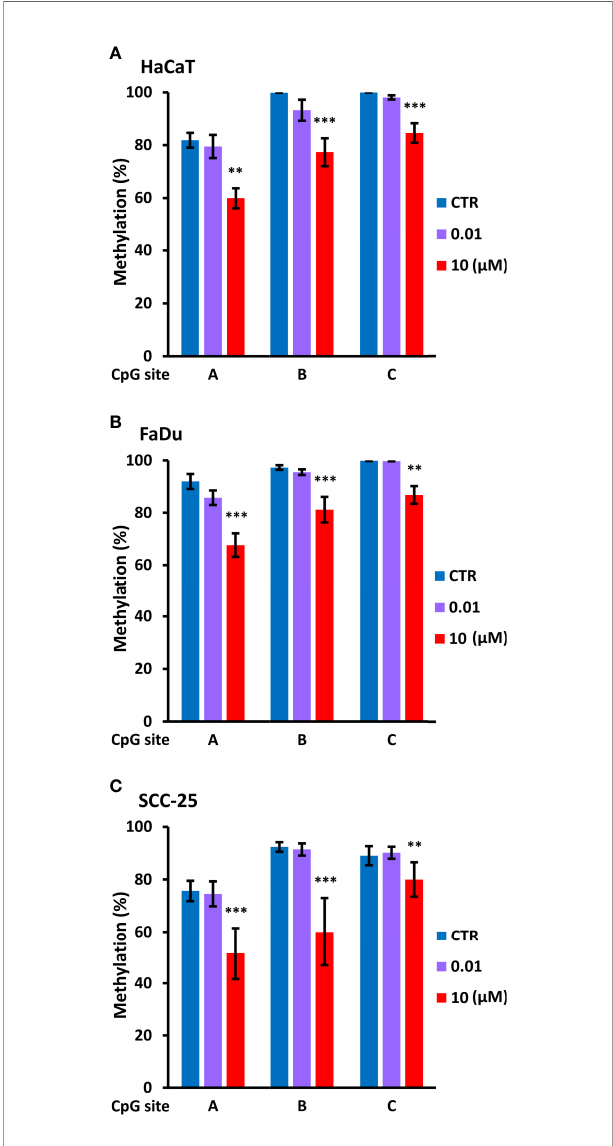
FIGURE 7 | Decitabine reduces DNA methylation at the TAp63 promoter. The indicated cell lines were untreated (CTR, DMSO only) or treated with 0.01 µM or 10 µM decitabine for four days. DNA was extracted and bisul fi te converted, and PCR products were sequenced to analyze CpG methylation at each of the three individual CpG sites (A – C) . Plots show percentage methylation (n = 2 to 3 biological replicates). Statistical comparisons compare each CpG site in control cells with the same site in decitabine treated cells. **p < 0.01; ***p < 0.001.